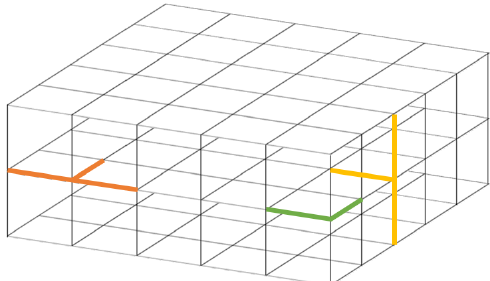
along the third. The product of X over the sets of colored links give the respective cube terms on the boundary. Figure 9: Geometry of smooth and rough boundaries in the X-cube